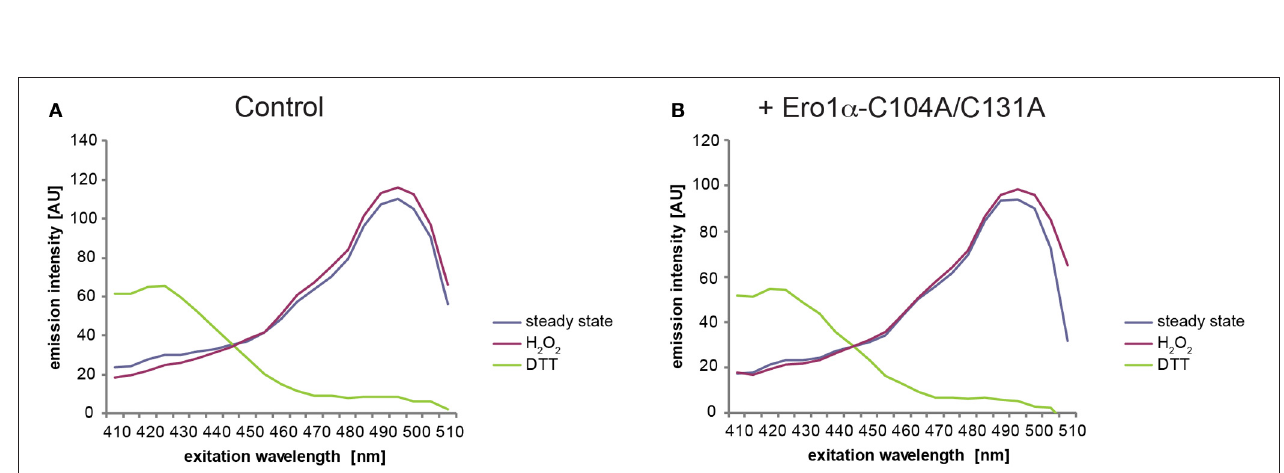
375nm excitation (B) , which overlapped with the fluorescence produced by Dox alone when added to untransfected cells (D) . The same effect was observed using ratiometric laser scanning fluorescence microscopy, as evidenced by ubiquitous fluorescence upon excitation (ex) with the 405nm laser line (C) .